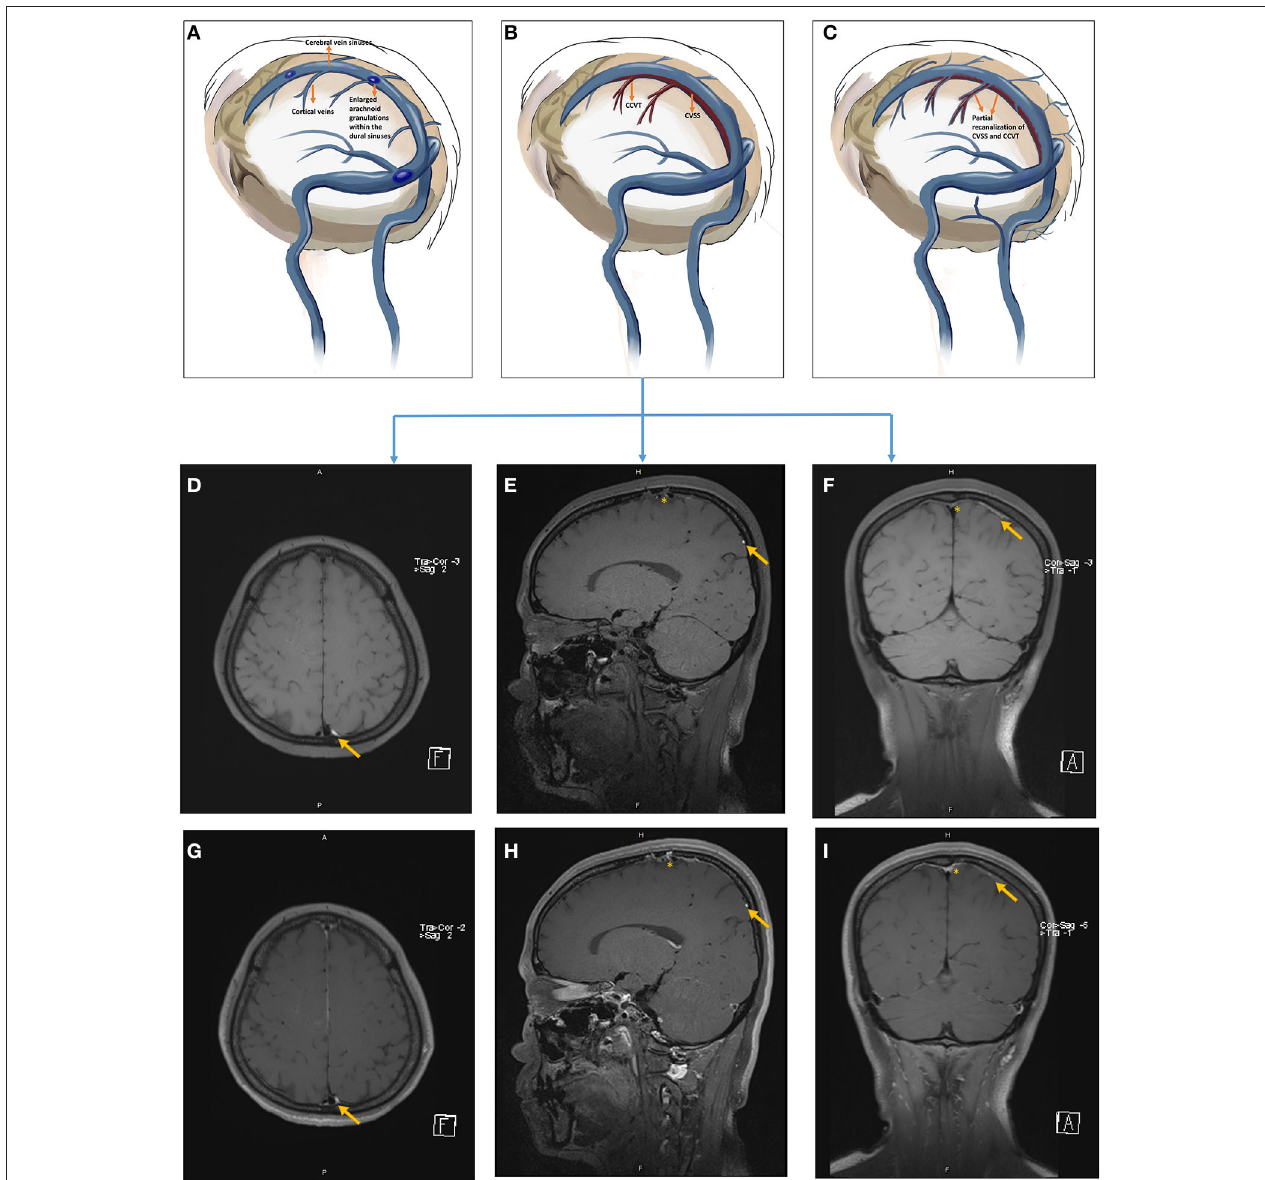
FIGURE 4 | The pathophysiology of hemorrhagic transformation associated with CCVT (A–C) and follow-up of non-enhanced (D–F) and contrast-enhanced (G–I) HR-MRBTI of the brain in Case 2 (on admission, D,G ; 2-week follow-up, E,H ; 6-week follow-up, F,I ). The orange asterisk represents CVSS, and the orange arrow indicates CCVT. Initially, CCVT was accompanied by surrounding edema (A,D,G) ; but hemorrhagic transformation would likely arise if standard anticoagulation and hydration therapy were not administered appropriately (B,E,H) . Parenchymal edema and the hematoma were gradually absorbed, and the lesion underwent neural recovery (C,F,I)